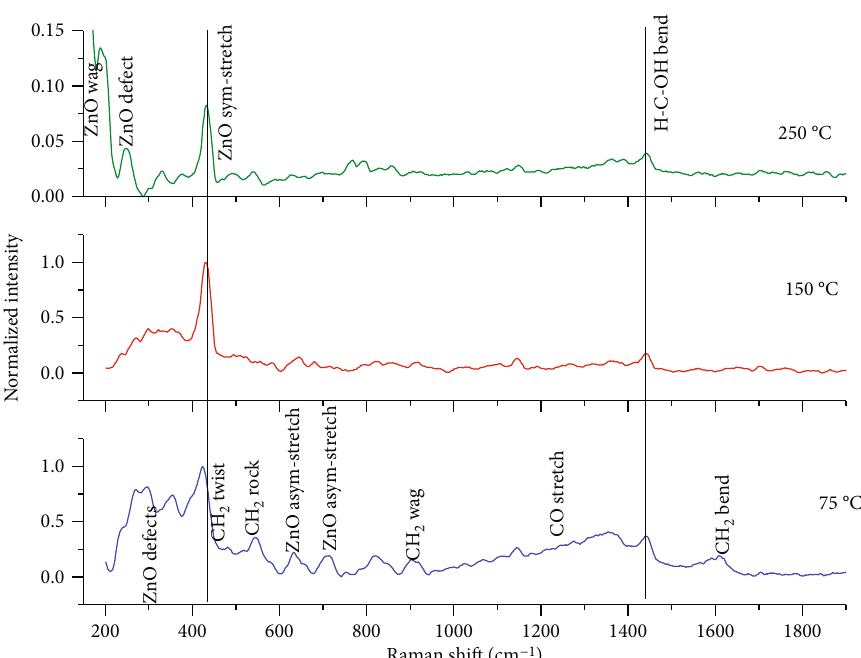
Figure 7: Raman spectra of the poly(vinyl alcohol)- (PVA-) fi lled layered double hydroxide composite fi bers (samples CF75, CF150, and CF25) are plotted vertically in order of increasing annealing temperature. The positions of characteristic vibrations of ZnO and PVA are marked by vertical lines on the